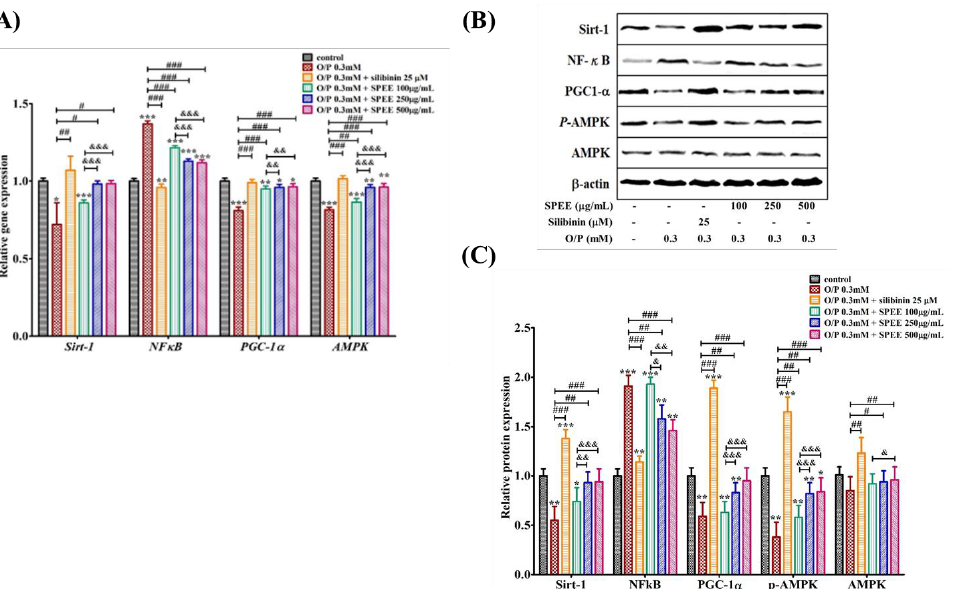
Figure 8. The effects of SPEE on O/P-induced m-RNA ( A ) and protein expressions ( B and C ) in HepG2 cells. HepG2 cell lines were co-treated with 0.3 mM O/P and SPEE (100, 250 and 500 μ g/mL, respectively) for 24 h. Silibinin was used as the positive control. Data are expressed as mean ± SD from triplicate experiments. * p < 0.05, ** p < 0.01 and *** p < 0.001 vs. the control group. # p < 0.05, ## p < 0.01 and ### p < 0.001 vs. the O/P group. & p < 0.05, && p < 0.01 and &&& p < 0.001 vs. the O/P 0.3 mM + SPEE 100 μ g/mL group.